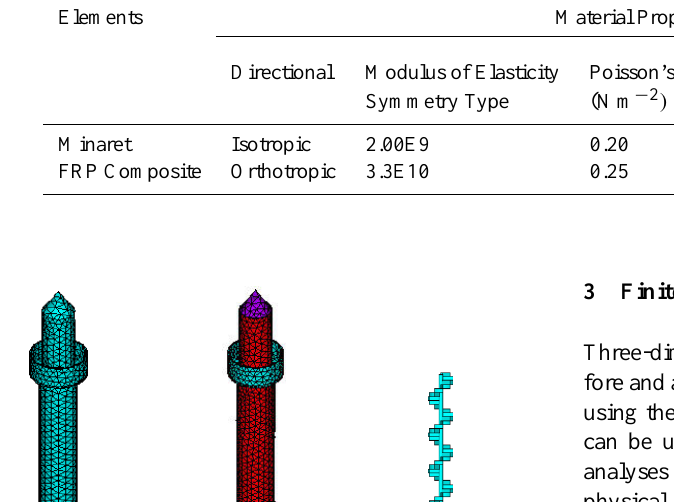
Table 1. Material properties used in analyses of the minaret.